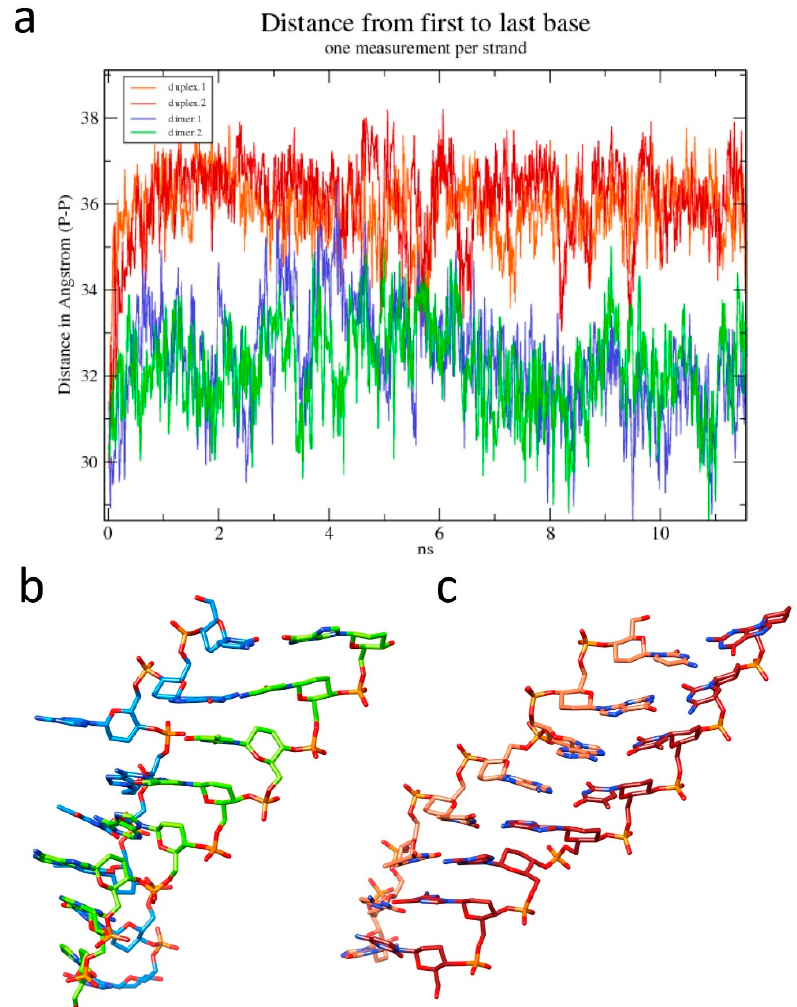
Figure 6. Changes in the length of the homo-DNA octamer during simulation. ( a ) Plot of the fluctuating intra-strand distances between the first and last phosphate groups. Distances for the duplex from the dimer are shown in blue / green and those for the isolated duplex are in orange / red. Only the initial 12 ns of the simulation are shown here. Snapshots of ( b ) one of the duplexes from the dimer and ( c ) the isolated duplex with colors of carbon atoms matching those in the plot in panel ( a ).